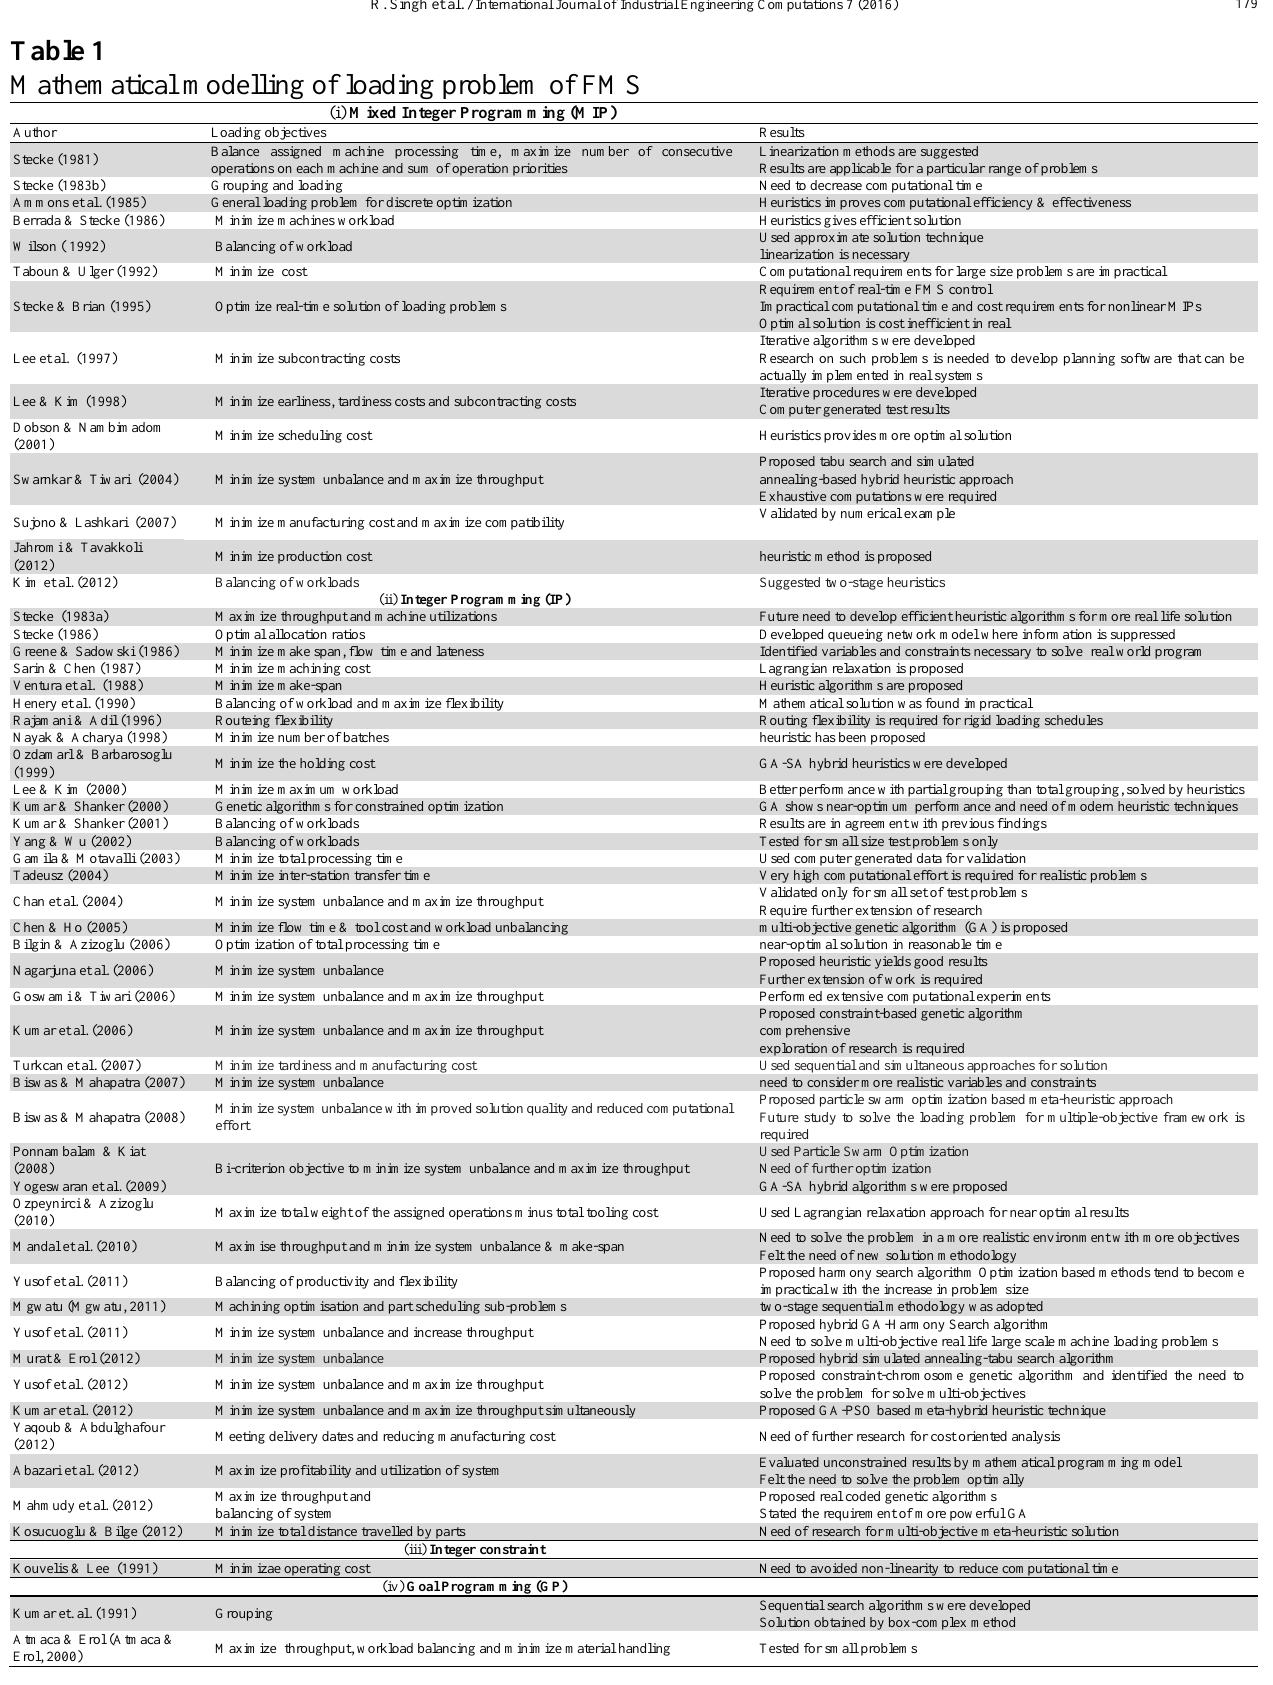
Proposed hybrid simulated annealing-tabu search